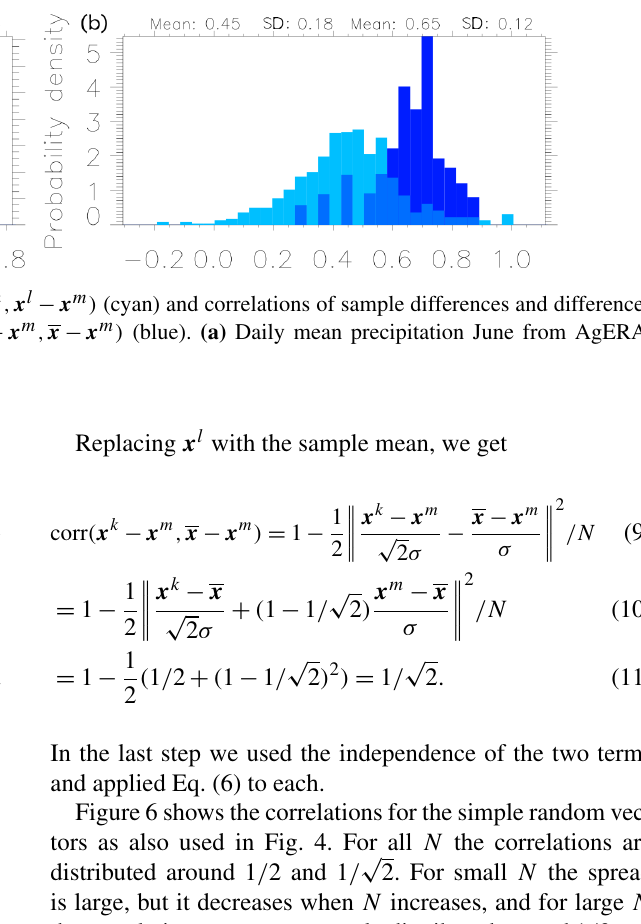
Figure 6. Correlations as a function of dimension N . For each N we draw 50 N -dimensional random vectors and calculate correlations of pairs of sample differences (blue, corr ( x k − x m , x l − x m ) ) and correlations of sample differences and differences between ensemble mean and individual ensemble members (black, corr ( x k − x m , x − x m ) ). The thick curves show the mean of the correlations and the broken curves the mean ± 2 standard deviations. In (a) each component of the vectors is drawn from a standard Gaussian; in (b) each component is drawn from a Gamma distribution (see caption to Fig. 4). The horizontal black lines indicate 1 / 2 and 1 /